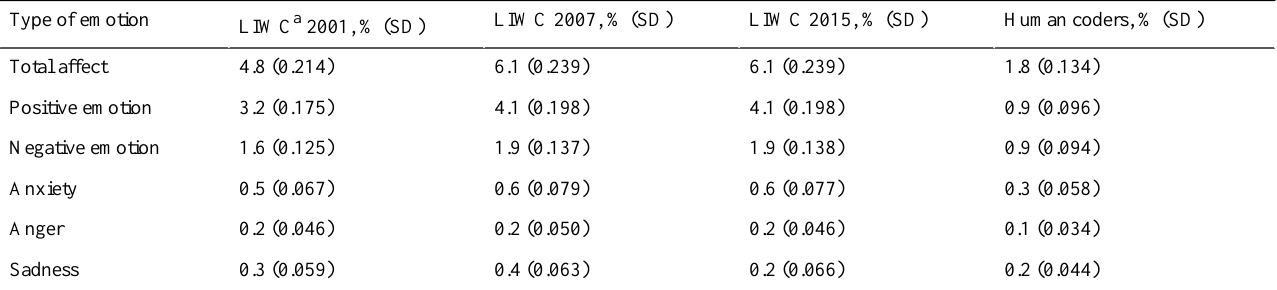
Table 1. Linguistic Inquiry and Word Count 2001, 2007, 2015, and human coder average of words identified in each emotional category and